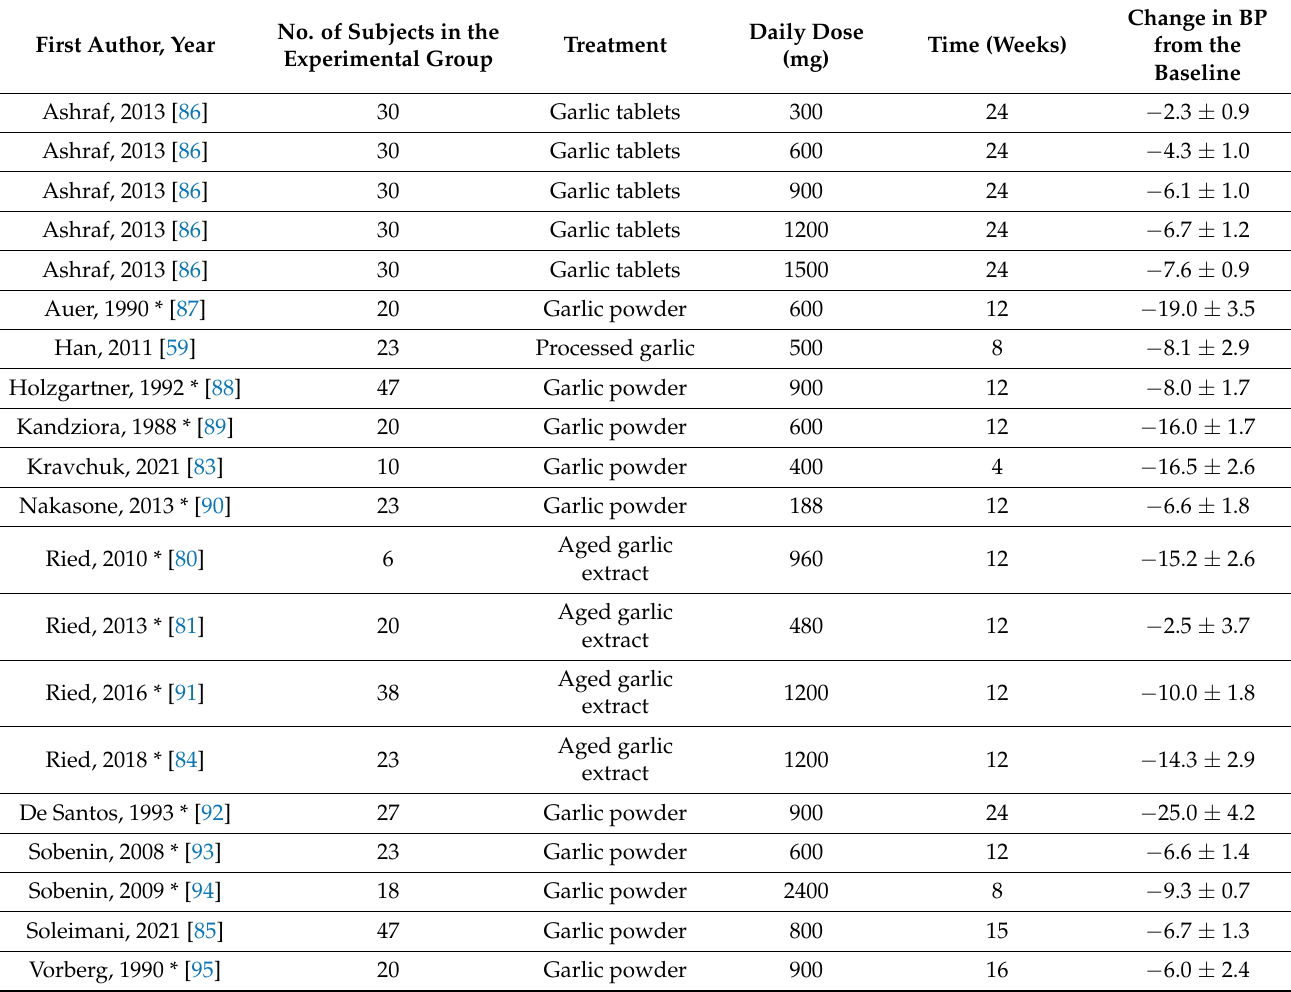
Table 3. Antihypertensive effects of garlic and garlic polysulfides in clinical studies. All values refer to systolic blood pressure (BP) expressed in mmHg and reported as mean ±